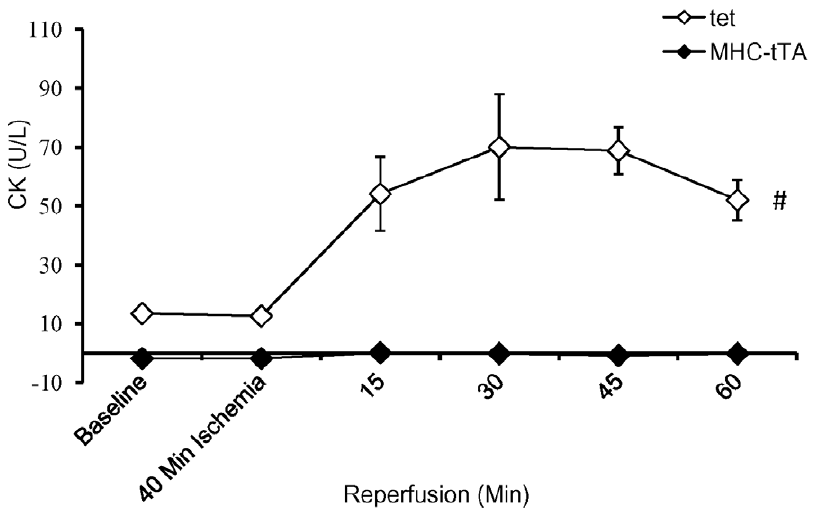
Figure 3. Reduced cardiac muscle damage in a -MHC-tTA hearts subjected to I/R injury. Lack of cardiac muscle cell damage was apparent in a -MHC-tTA compared to control where abundant creatine kinase levels were observed within 15 min of start of reperfusion. (N=4, p , 0.05).